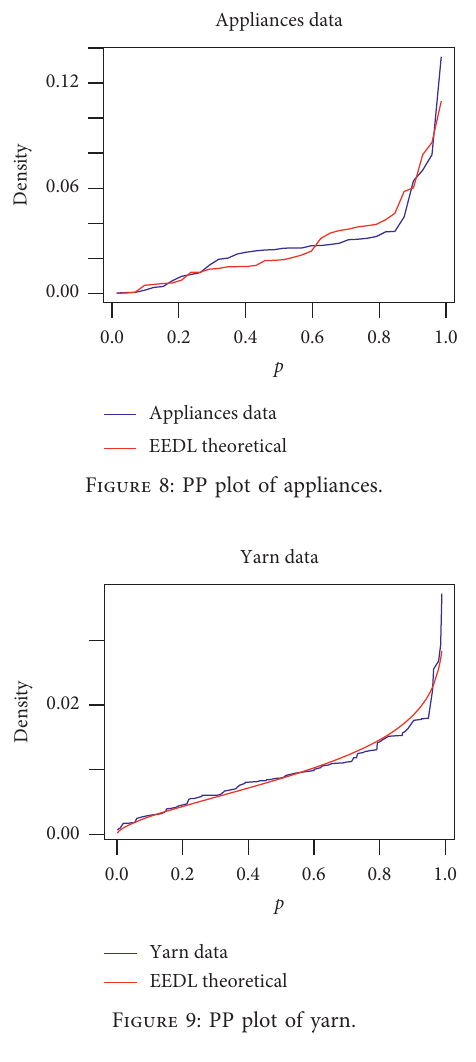
Figure 9: PP plot of yarn.